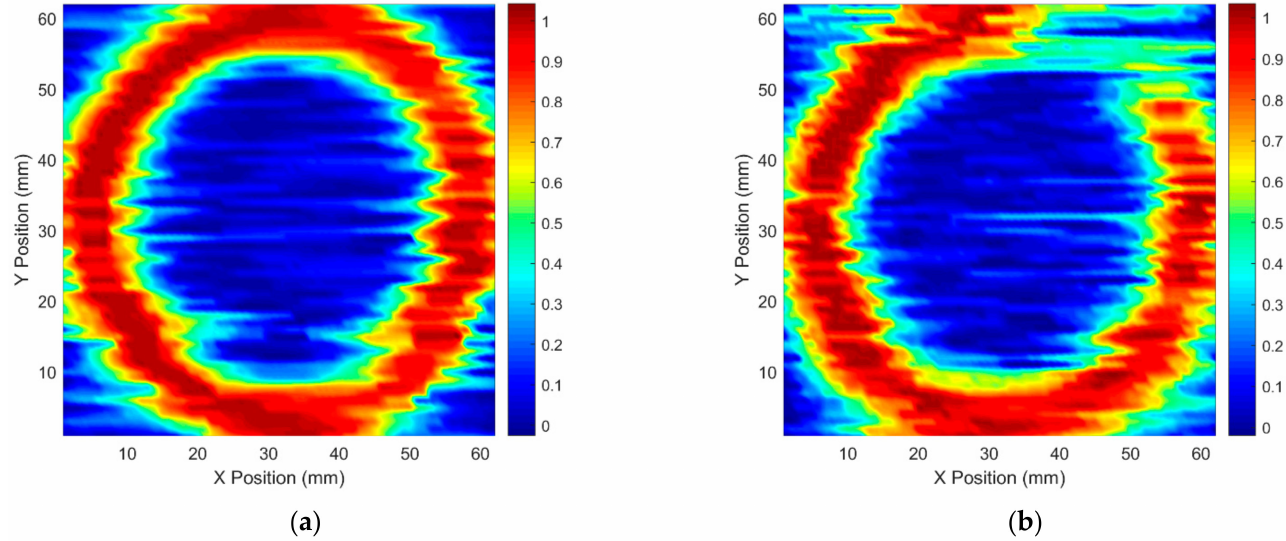
Figure 12. C-scan images for ( a ) an intact and ( b ) an incomplete brazing foil, respectively.